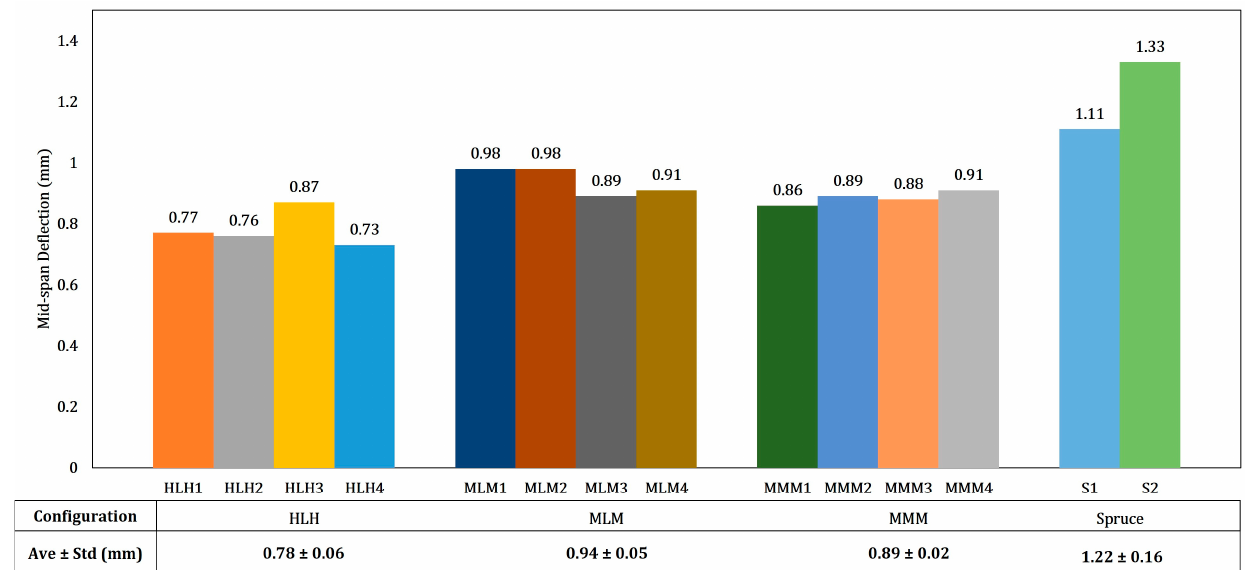
Figure 5. Test results of the mid-span deflection under 1.83 kN of serviceability load.